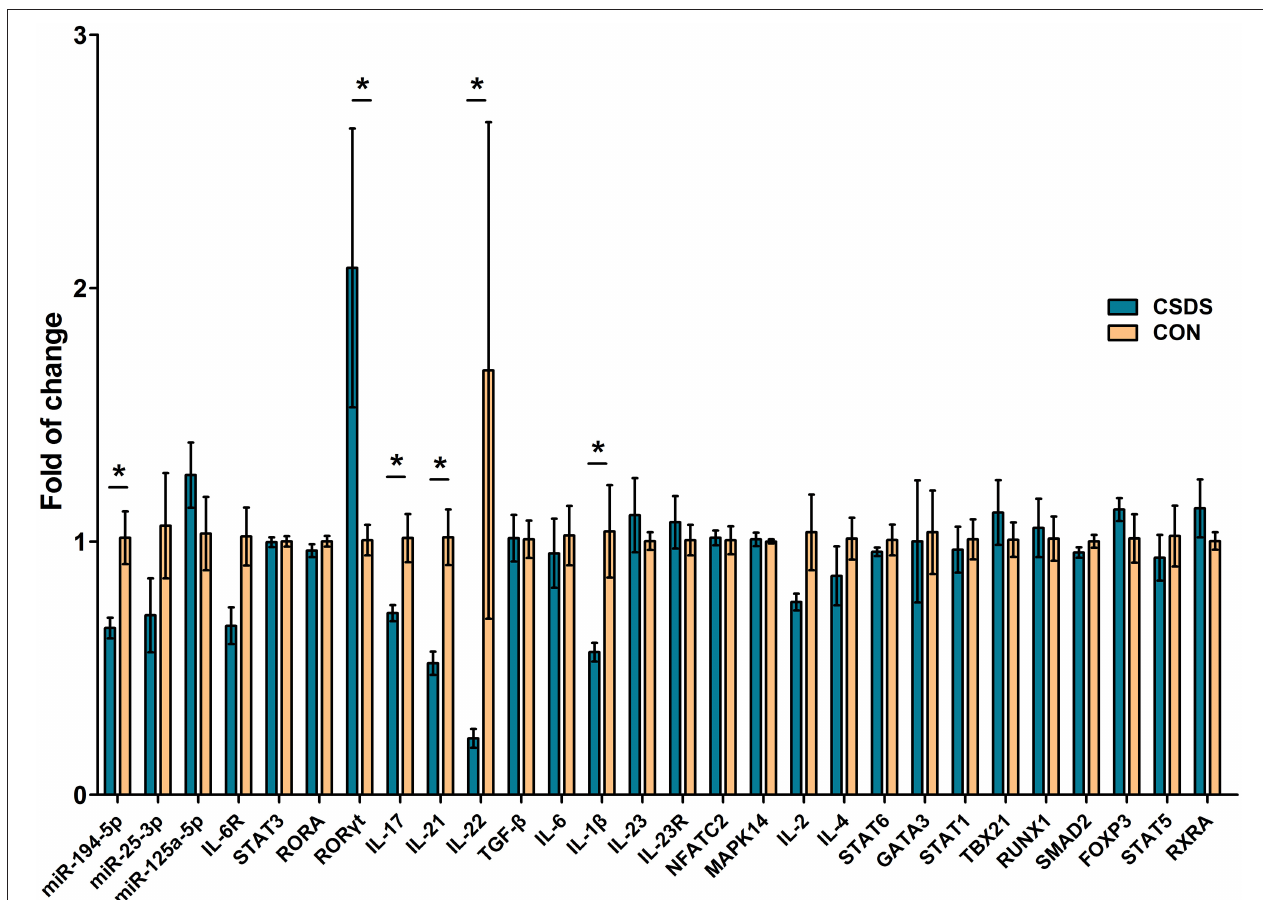
FIGURE 6 | Assessment of Th17 cell differentiation-related gene expression in the prefrontal cortex of CSDS mice by real-time polymerase chain reaction. Data represent the mean ± SD. * p <